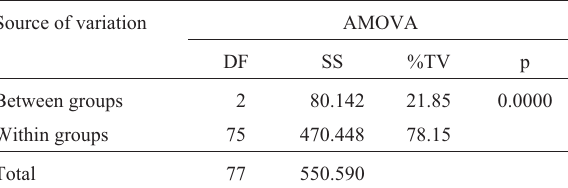
Table4 -Analysisofmolecularvariance(AMOVA)ofmicrosatellitedata for 78 sweet potato ( Ipomoea batatas ) accessions (landraces and clones) from the Vale do Ribeira, São Paulo, Brazil. The accessions were distrib- utedintothreegroupsbyprincipalcoordinateanalysiswherethefirstprin- cipal component explained 14.48% of the total variation and the second principal component explained 7.40% of the total variation . See also Fig- ure 3. The table shows degrees of freedom (DF), sum of squares (SS), per- centage of total variation (%TV) and the probability (p) value for 1023